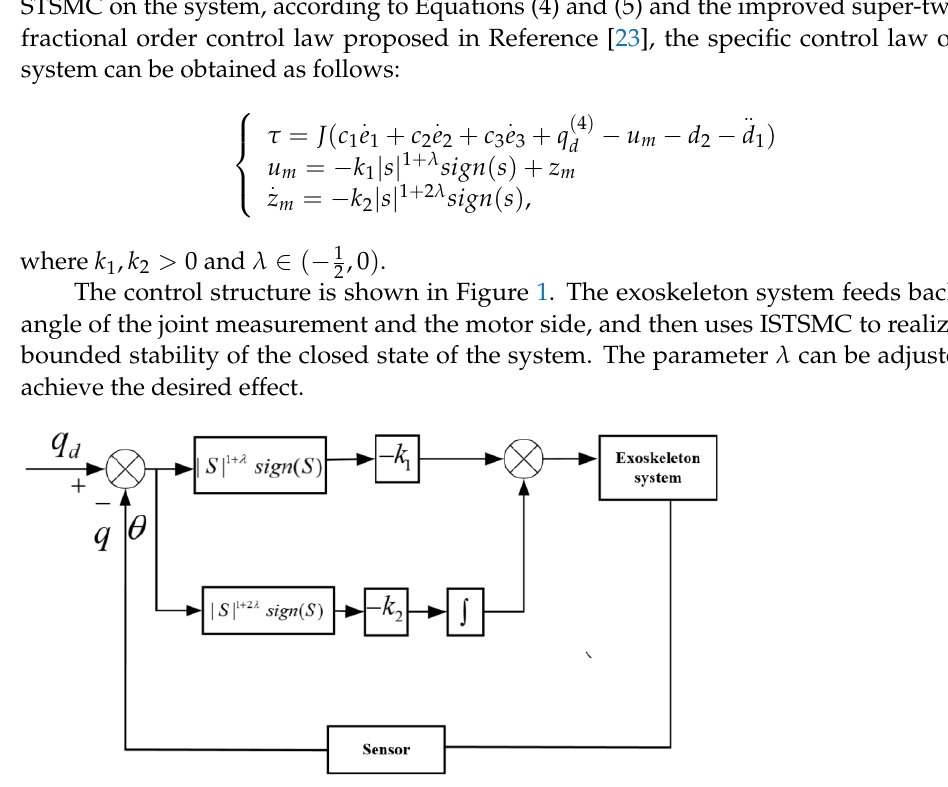
Figure 1. ISTSMC for exoskeleton system.